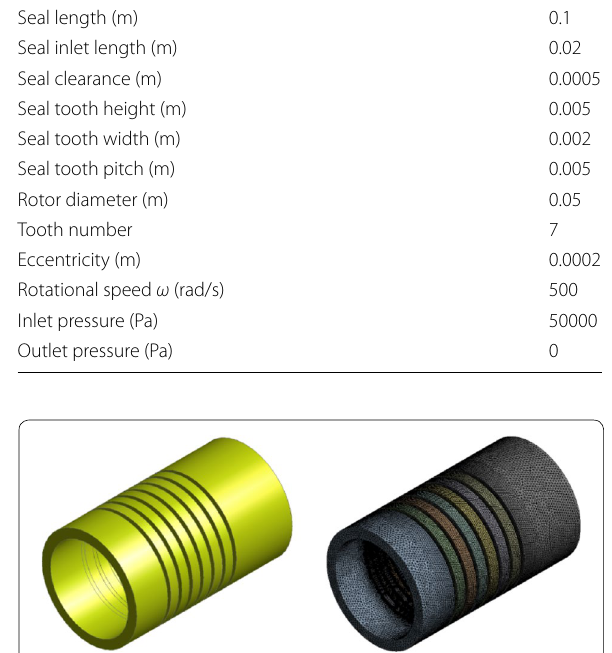
Figure 2 Computational model and mesh of the RSTLGS